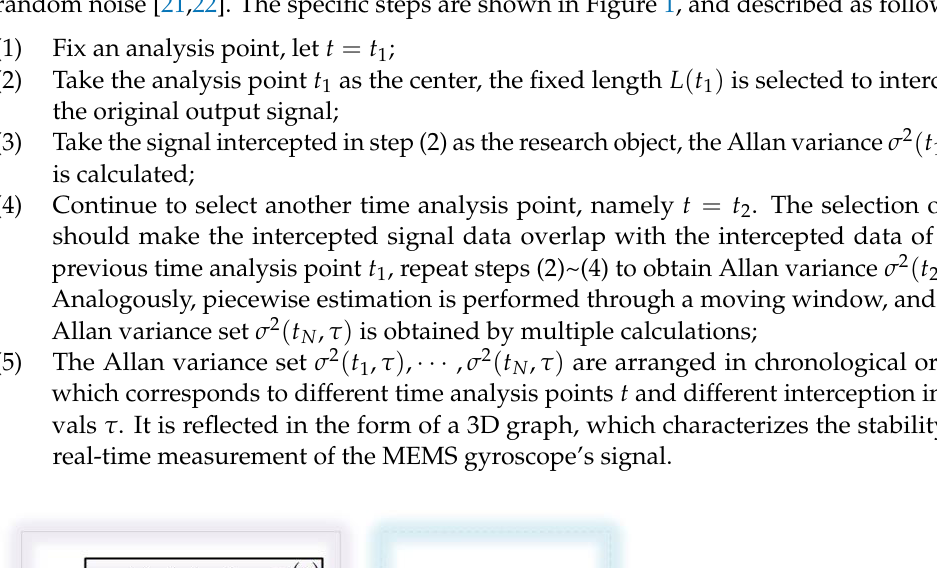
Table 1. Parameter estimation and slope of noise term.